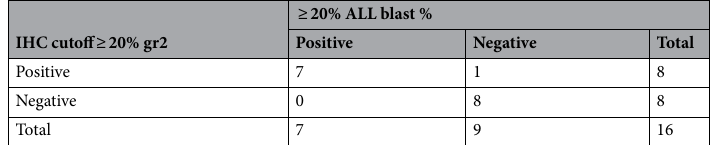
Table 2. AKR1C3 Singleplex IHC 2 × 2 analysis in T-ALL. Compared to the percentage of T-ALL disease involvement in the marrow AKR1C3 IHC sensitivity = 100%, and specificity = 88.9%.